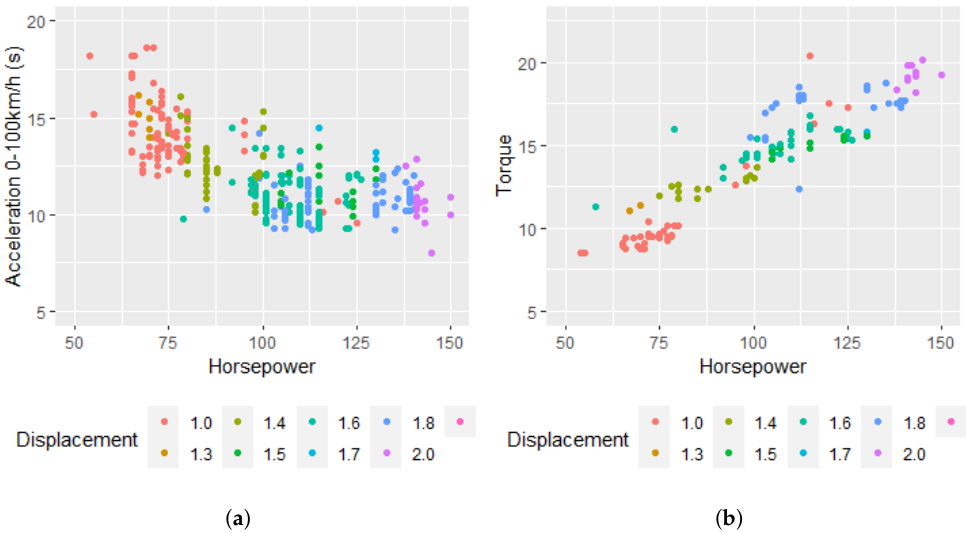
Figure 5. Torque, horsepower, and acceleration as a function of displacement. ( a ) Acceleration vs. Horsepower; ( b ) Torque vs.